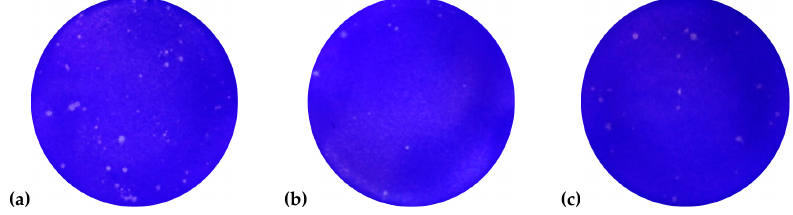
Figure 6. Preventive plaque assay – H1-HeLa cell monolayer with plaques dyed with crystal violet: ( a ) untreated control, RV-14 was applied directly onto the cells, ( b ) isla Conc. 2 (0.115 g lozenge / mL), applied before RV-14, ( c ) isla Conc. 3 (0.077 g lozenge / mL), applied before RV-14.